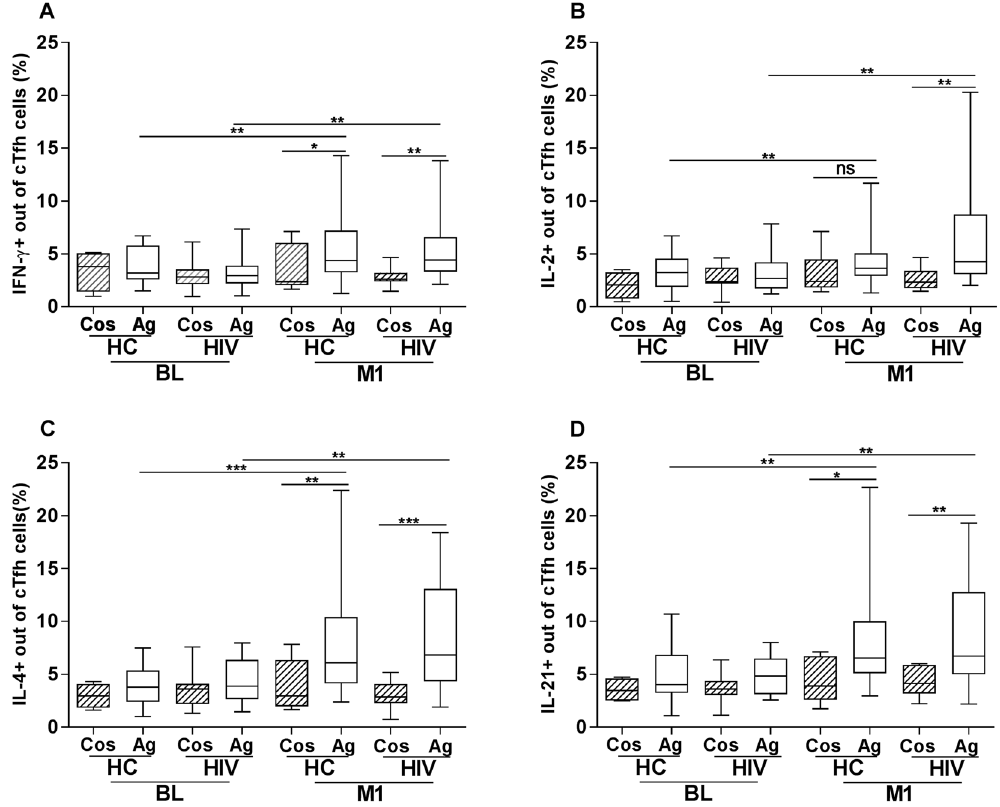
Figure 3. Expression of IFN- γ , IL-2, IL-4 and IL-21 by cTfh cells. The expression of cytokines IFN- γ , IL-2, IL-4 and IL-21 by cTfh cells in specimens from HIV-1 infected children and healthy controls after 5 days of culture is shown. Anti-human CD28/CD49d alone (Cos) or anti-human CD28/CD49d together with HBsAg protein (Ag) were added to the cultures. The expression of IFN- γ , IL-2, IL-4 and IL-21 among cTfh cells (Figure A – D ) in response to HBsAg is shown for 20 healthy controls and 20 HIV-1 infected children at baseline (BL) and for 31 HC and 26 HIV-1 infected children at 1 month (M1) after vaccination. Samples from HC (BL = 4 and M1 = 9) and HIV-1 infected children (BL = 8 and M1 = 10) were used in culture stimulated with the CD28/CD49d complex. ns = not statistical significant, * p < 0.05, ** p < 0.01 and *** p <